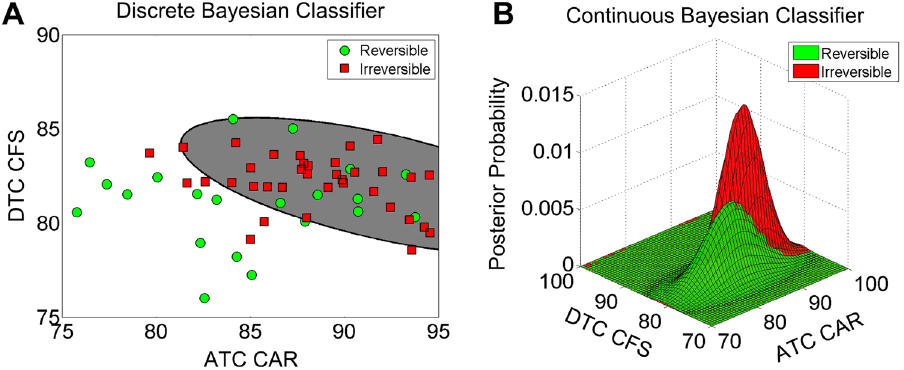
Figure 5. The discrete and continuous Bayesian predictive models for the HCV induced liver fibrosis reversibility. ( A ) The optimized discrete model using two selected features, ATC CAR and DTC CFS, and their distribution in the 2D feature space. ( B ) The optimized continuous model using ATC CAR and DTC CFS and their probability distribution function in the 2D feature